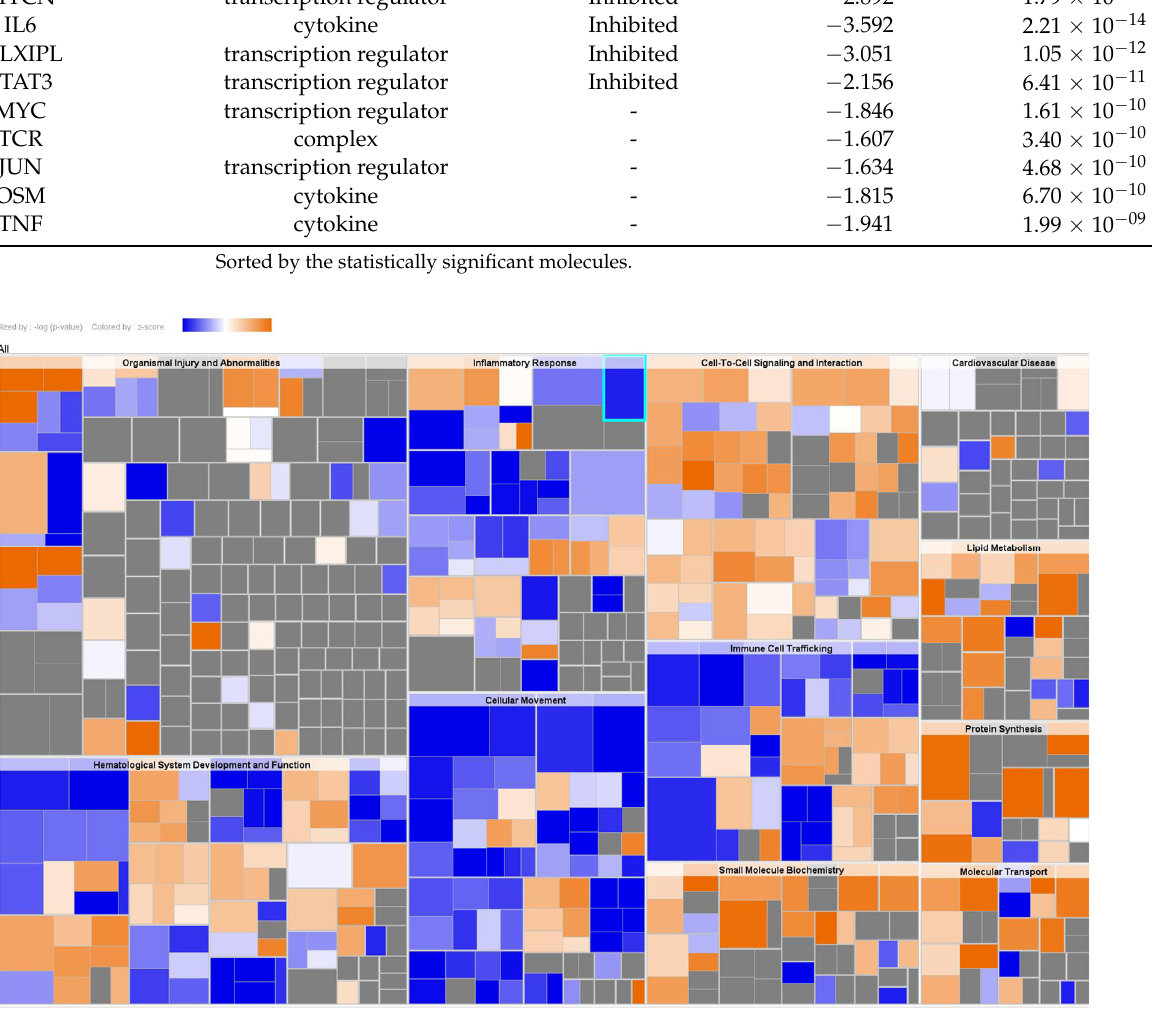
Figure 3. Disease and biofunction analysis of serum DEPs. A hierarchical heat map generated by disease and function analysis of serum DEPs. The main boxes represent related families of functions or categories. Each rectangle represents a specific annotation of a biological function or disease, and its color shows whether the status is predicted to be increased (orange) or decreased (blue). Higher absolute Z-scores are exhibited with darker colors. The size of the rectangles correlates with increased overlap significance ( p value). Table 4. Upstream regulators predicted by IPA.